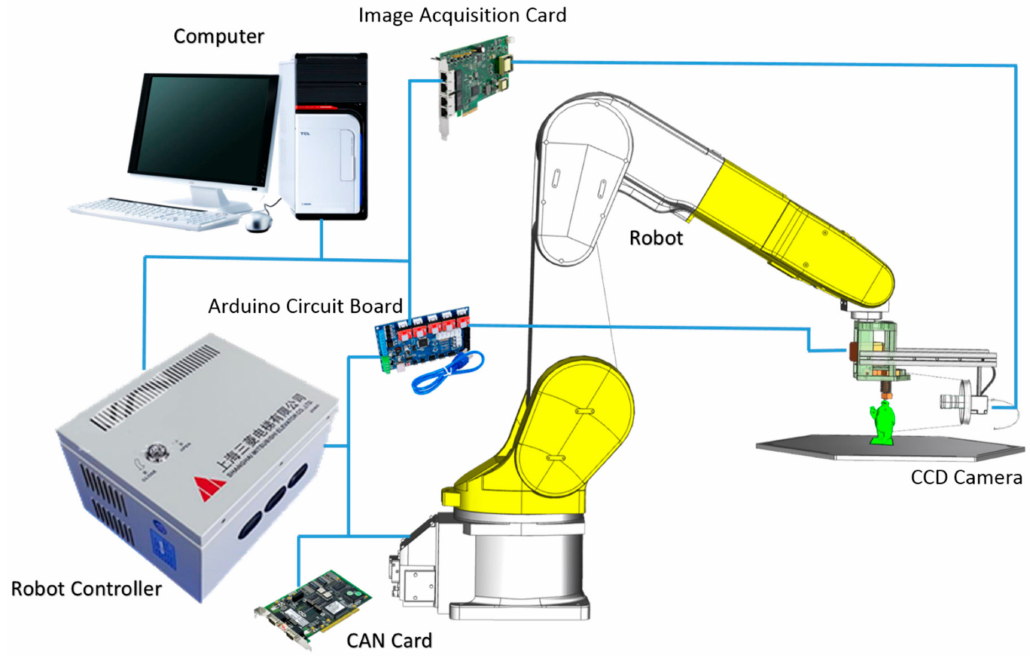
Figure 1. Hardware system structures of robot Fused deposition modeling (FDM)